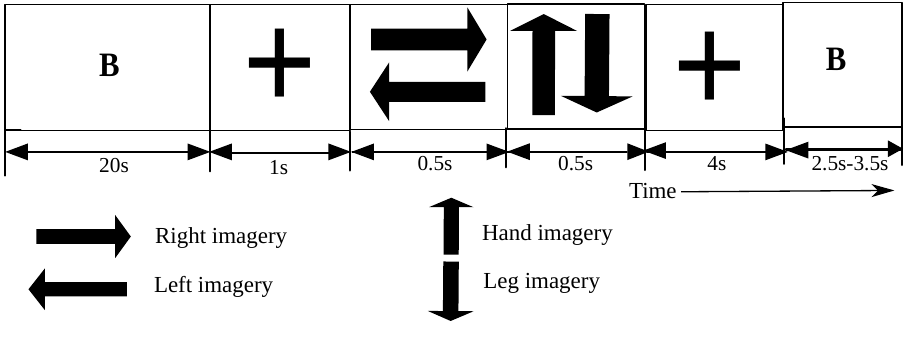
Figure 2. Sequence of visual cues displayed to the participants during the online neuro-feedback experiment. Each trial began with the display of a fixation cross, denoted by ‘+’ in the figure, followed by a left or right arrow indicating the left or right side of the body, and finally an up or down arrow to indicate whether to move the hand or foot. The second ‘+’ is the feedback period, which is the time interval of interest in this